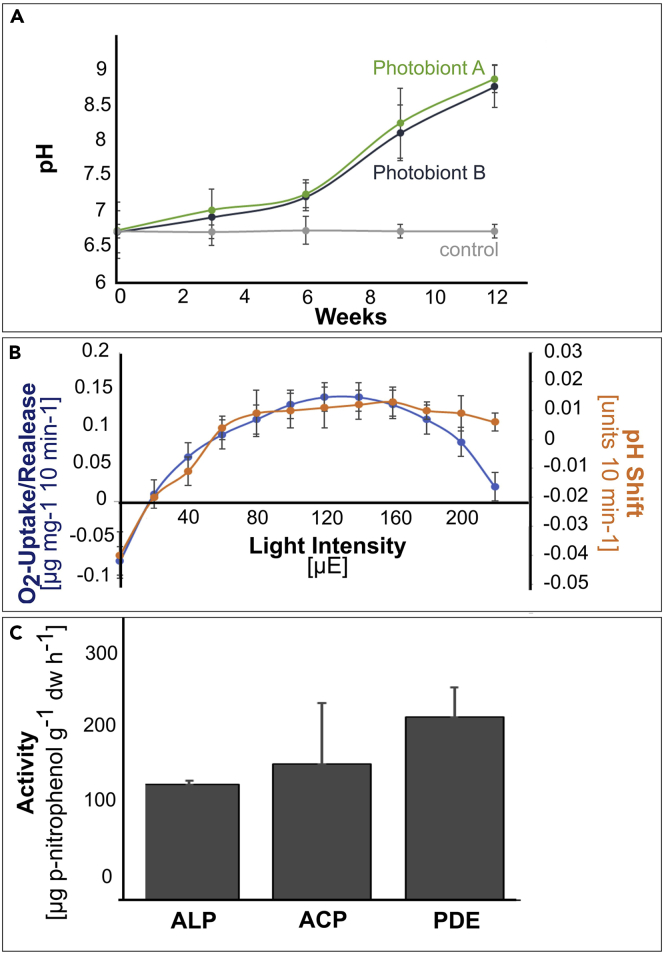
Alkalinolysis and Enzyme Activity of Grit Organisms(A) Long-term incubation of two isolated green algal photobionts (n = 3, for each photobiont and the control) indicating a raise in pH over the course of 12 weeks; (B) Short-term experiment with isolated green algal photobionts (n = 6) showing pH shifts depending on oxygen production during varying light conditions; (C) Enzyme activity of alkaline phosphatases (ALP), acidic phosphatases (ACP), and phosphodiesterases (PDE) (n = 3). Data represent mean +/− standard deviation.